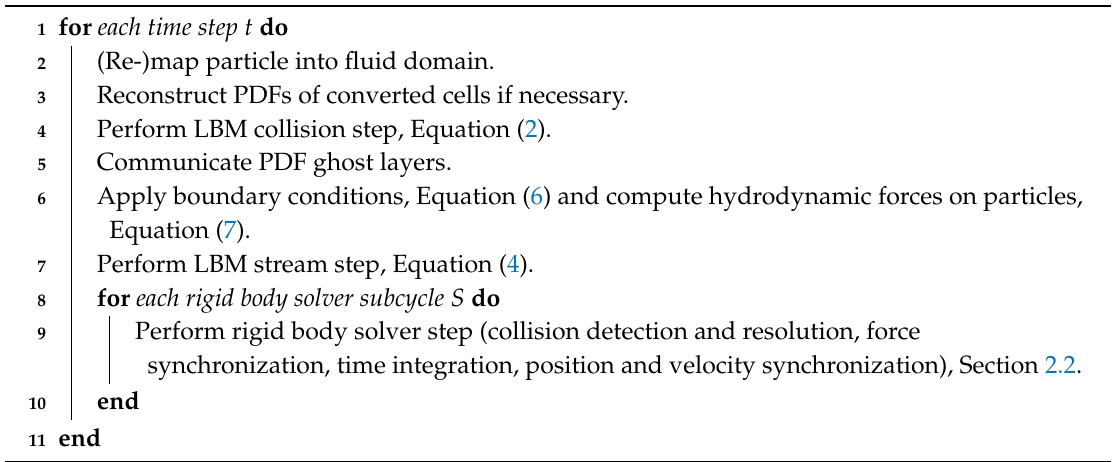
Algorithm 1: Coupled algorithm for particulate flow